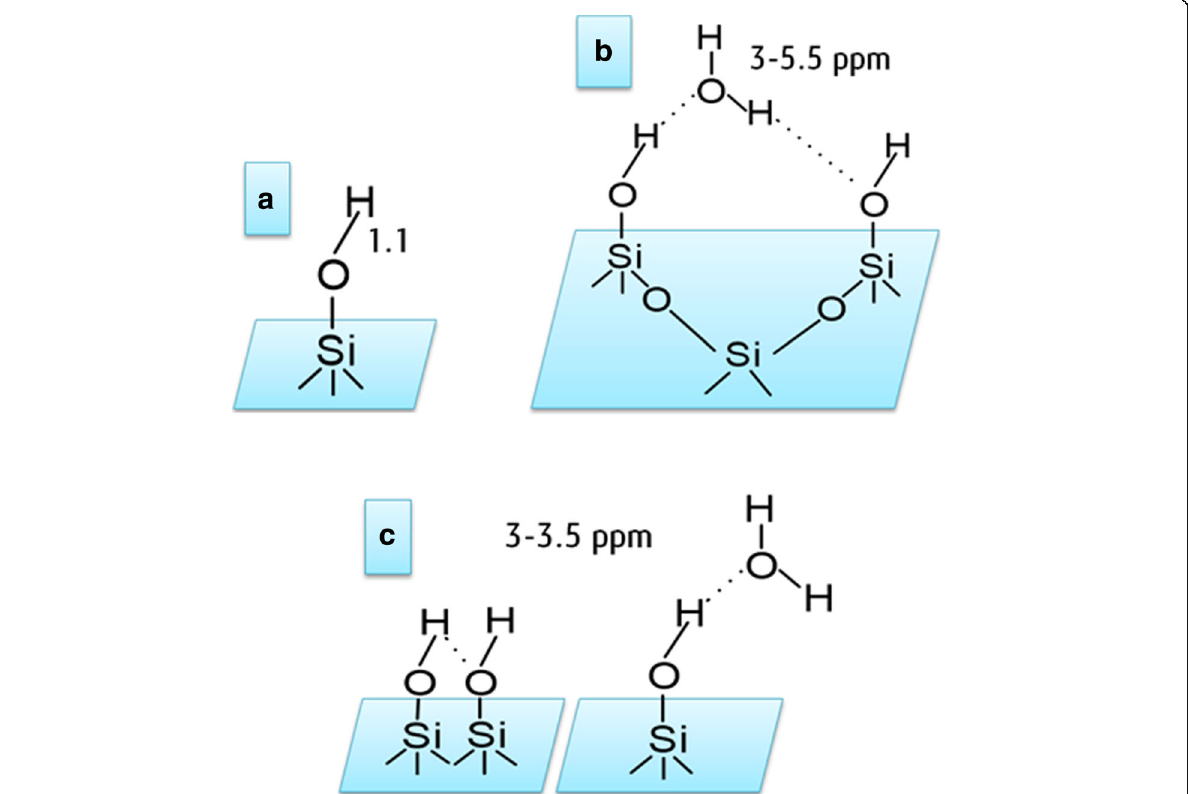
Fig. 2 Schematic representation of ( a ) single silanol groups and ( b , c ) possible structures involving the silanol groups and physisorbed water at the silica surface. The values of chemical shift are assigned to these structures according to refs [26, 27, 29]